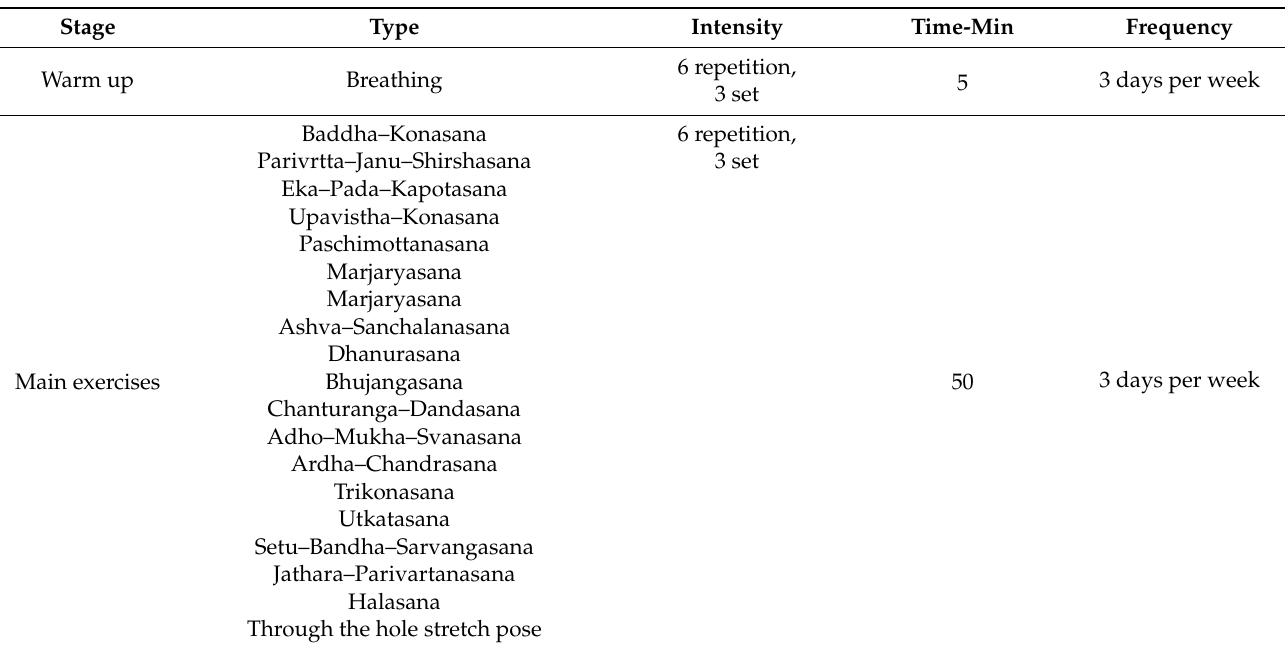
Table A4. The Pilates